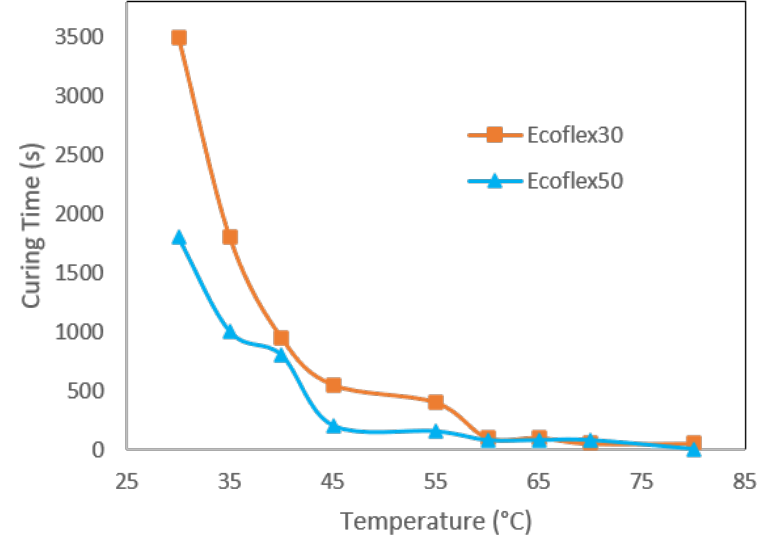
Figure 5. Plot of curing times (s) of Ecoflex30 (orange line) and Ecoflex50 (blue line) versus temperatures ( ◦ C).